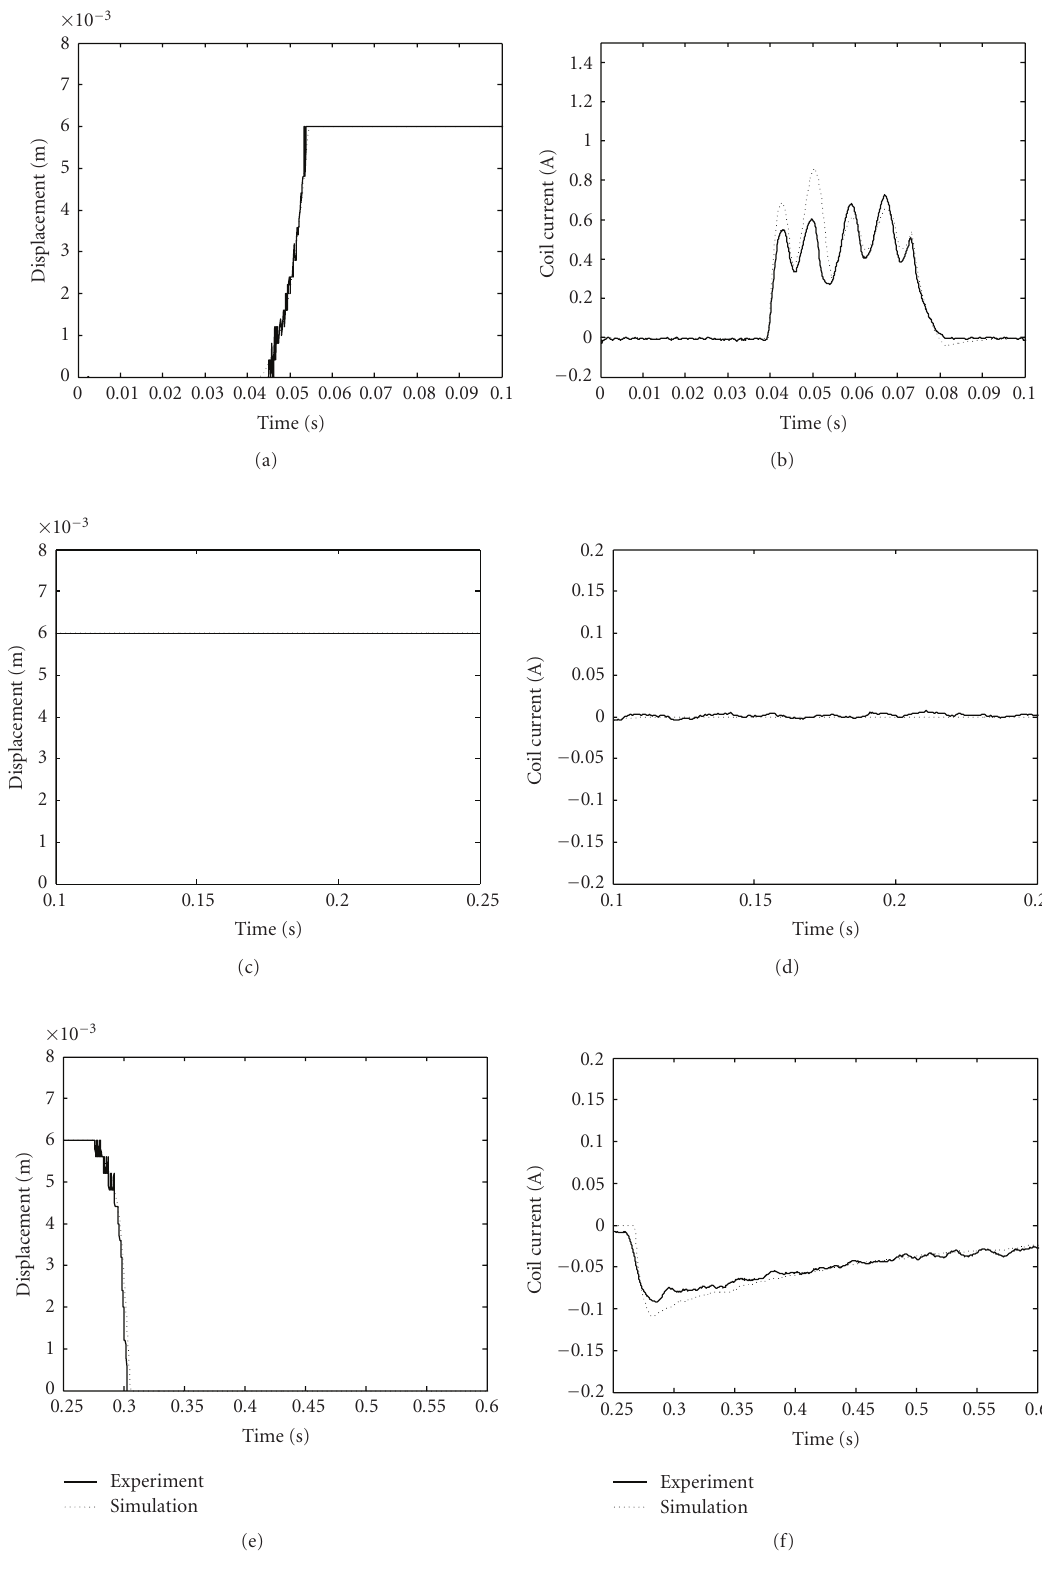
Figure 8: Time-varying waveforms of both armature displacement and coil current during the (a) closing process, (b) holding process, and (c) opening